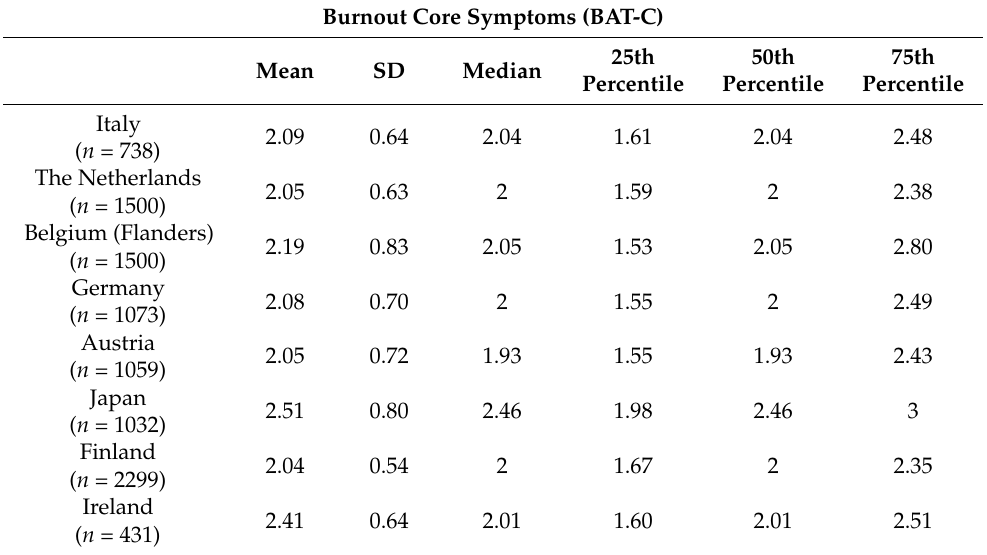
Table 8. Descriptive statistics of mean scores in burnout core symptoms assessed through the BAT-C across 8